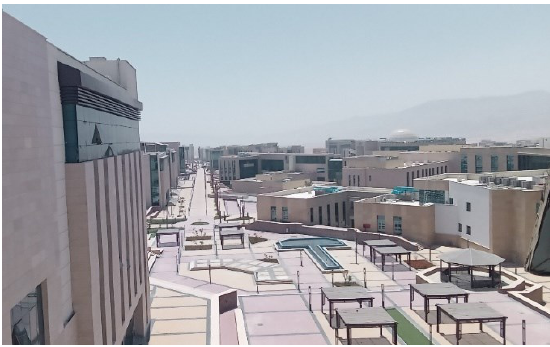
Figure 8. Galala University campus. (Source: